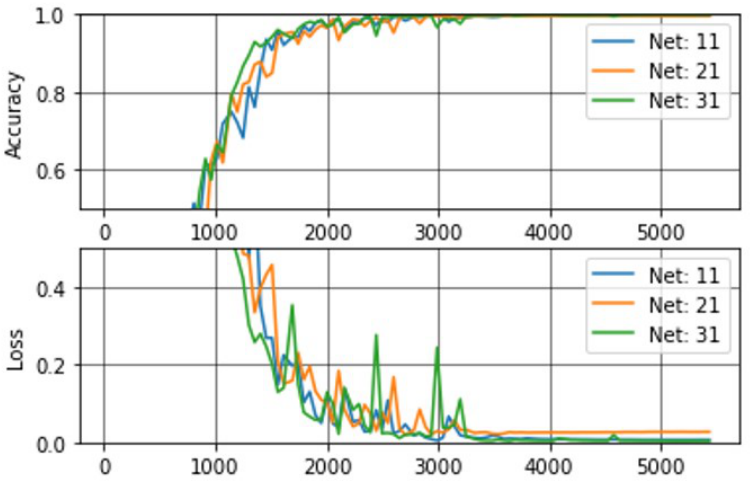
Figure 17. Accuracy and loss graphs during custom model trainings. The first index in each network corresponds to the dataset (i.e., 1 = DS1, 2 = DS2, 3 = DS3), while the second index corresponds to the freezing point (i.e., 1 = UF, 2 = MF, 3 = TF).